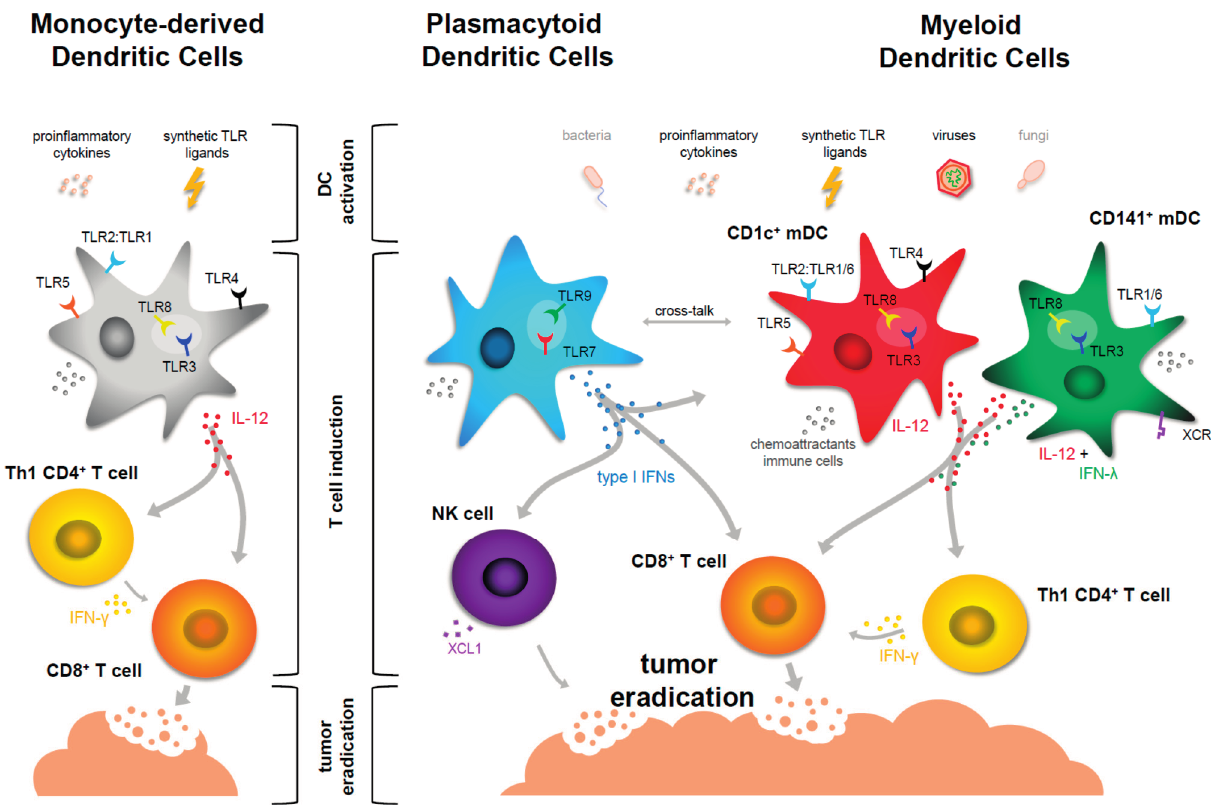
Figure 1. Maturation of moDCs and primary human DCs in the context of cancer immunotherapy. Stimulatory signals for human primary blood DCs include PAMPs from bacteria and viruses, but also proinflammatory cytokines. For cancer vaccine purposes, they can be matured by synthetic TLR ligands imitating natural ligands of TLRs. Monocyte-derived DCs used for DC-cell based cancer therapy are matured by proinflammatory cytokines or TLR ligands. TLR ligands mimicking viral infections—such as polyI:C (TLR3), R848 (TLR7/8) and CpG (TLR9)—have been proven most